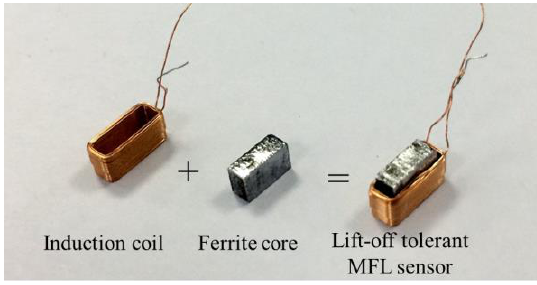
Figure 6. The diagram of the lift-off-tolerant MFL sensor.